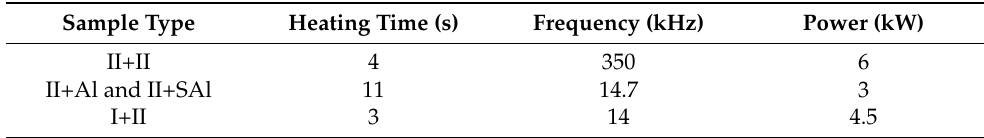
Table 2. The effective parameters of the ICJ. SAl: sand-blasted aluminum. Sample Type